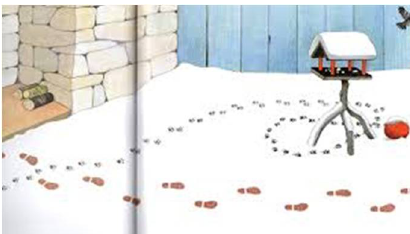
Figure 8. Muller G., Indovina che cosa succede. Una passeggiata invisibile; Babalibri, Italia 2001,